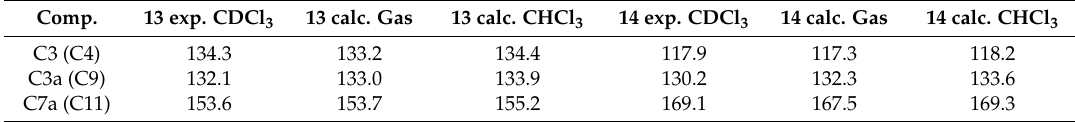
Table 3. Comparison of experimental and calculated 13 C chemical